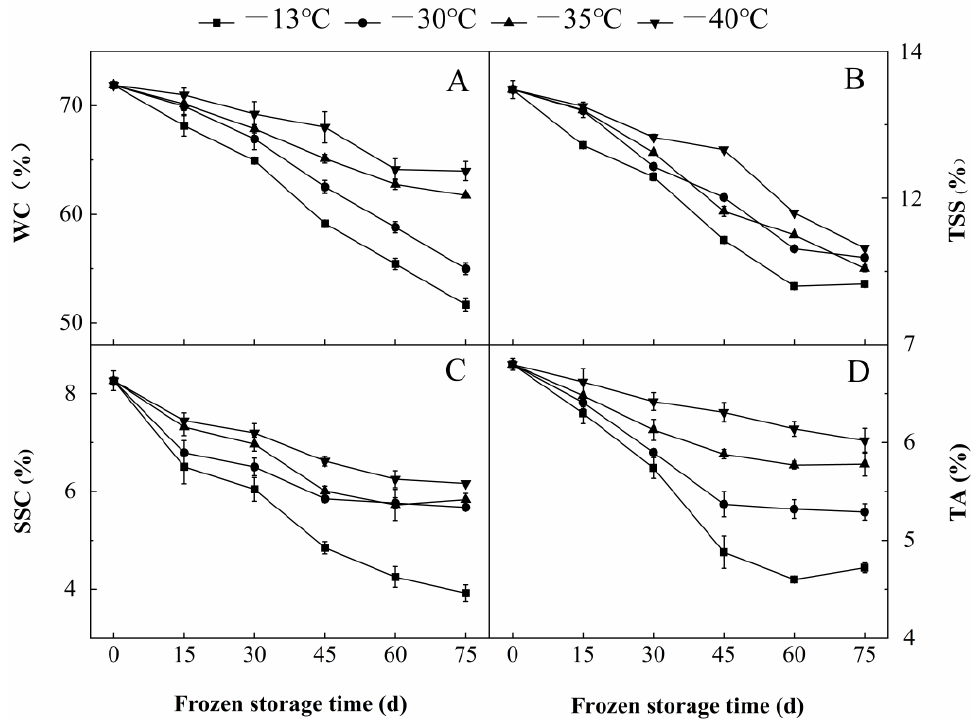
Figure 2. Effect of freezing time and temperature on the ( A ) WC, ( B ) TSS, ( C ) SSC and ( D ) TA of sea buckthorn berries. Bars indicated standard error (±SD). The - ■ -, - ● -, - ▲ -, - ▼ - show the freezing temperature of − 13, − 30, − 35 and − 40 ◦ C, respectively. The data are mean values of three replicates. AA, TFC and TPC were important antioxidant components of sea buckthorn berries [29,30]. With the extension of freezing time, the contents of AA, TFC and TPC of the berries steadily decreased. The contents of AA, TFC and TPC of berries stored at − 30 ◦ C for 45 d were lower than those at 0 d by 20.5%, 47.0% and 35.5%, respectively. The contents of AA, TFC and TPC of the fruits frozen at − 30 ◦ C for 75 d were 24.9%, 51.4% and 38.0% lower than those at 0 d, respectively (Figure 3). As the freezing temperature decreased, the contents of AA, TFC and TPC of the berries decreased. The contents of AA, TFC and TPC of the berries at − 30 ◦ C for 45 d were 3.7%, 15.9% and 15.8% higher than those at − 13 ◦ C, respectively. The contents of AA, TFC and TPC of the berries at − 40 ◦ C for 45 d were lower by 11.5%, 41.5% and 31.1% than those stored at − 13 ◦ C (Figure 3). With prolonged freezing time, ice crystals could disassemble the structure of berry cell membrane, leading to the destruction of substrate and enzyme separation and the increase of contact probability [3]. AA was oxidized by ascorbic acid oxidase (AAO) [4]. TFC and TPC were easily oxidized by polyphenol oxidase (PPO) and peroxidase (POD) [31]. With the decrease in freezing temperature, the integrity of the fruit cell membrane was maintained [24], and the oxidation rates of AA, TFC and TPC decreased [32].